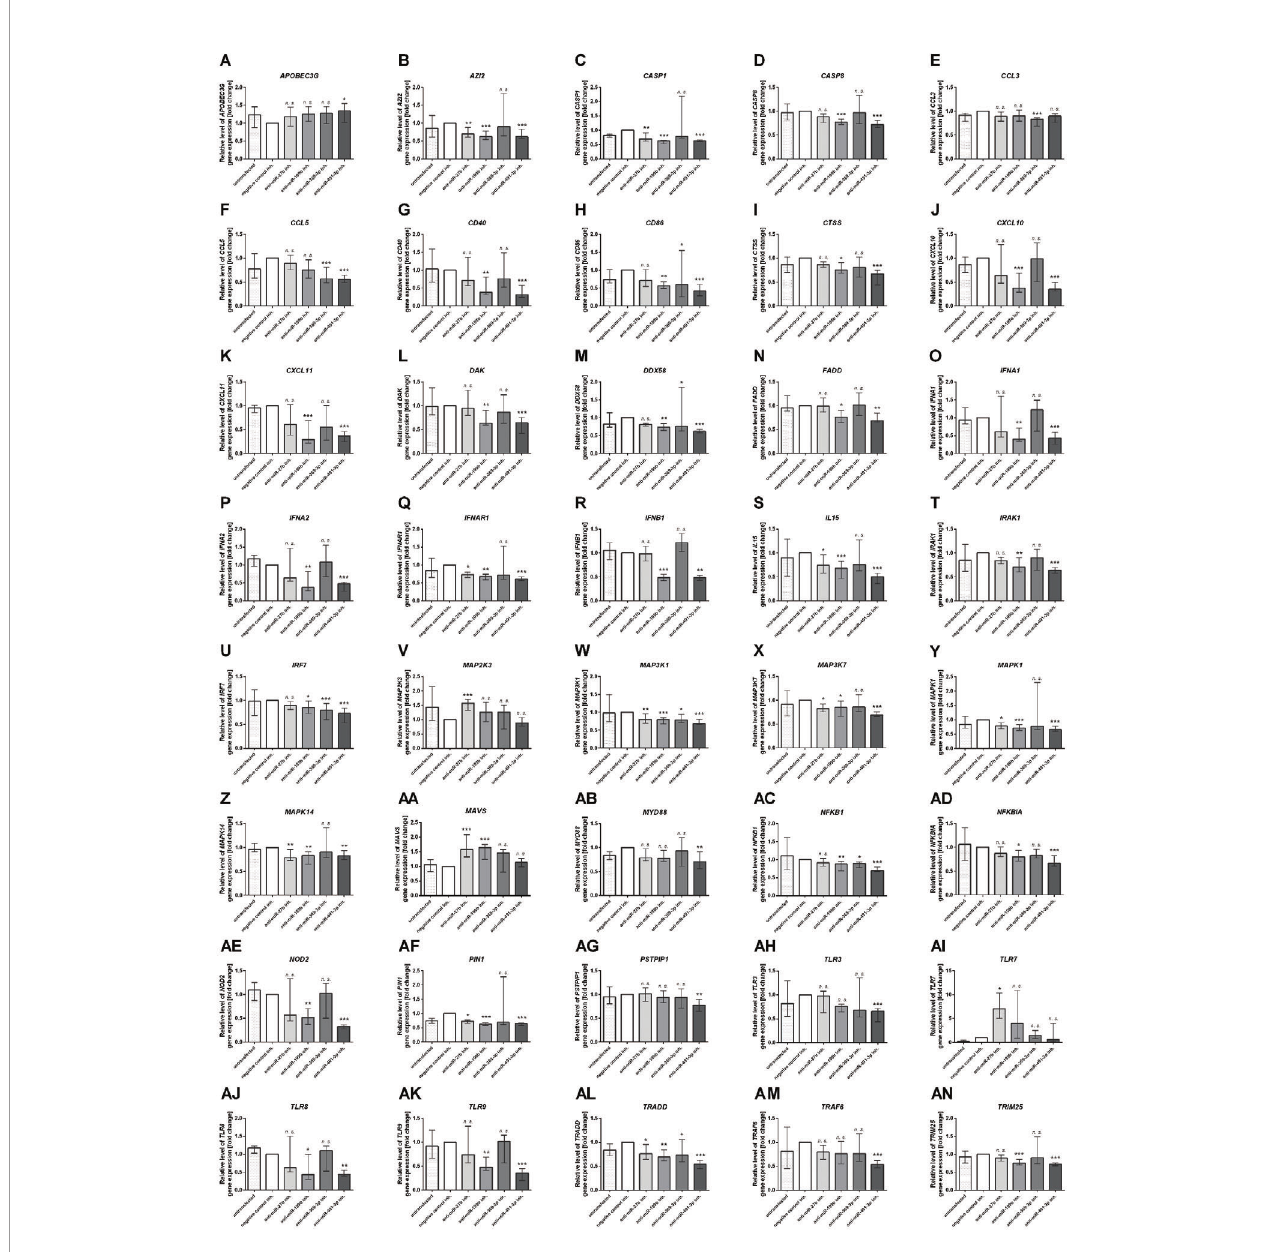
FIGURE 2 | Antiviral gene expression analysis. The effect of miR-27b, miR-199b, miR-369-3p and miR-491-3p inhibition in NK-92 cell line on antiviral response gene expression analyzed by real-time PCR presented as relative expression normalized to GAPDH (2 − DD CT ). Only genes which expression was signi fi cantly altered by at least one of the inhibitors are presented on the plot. APOBEC3G (A) , AZI2 (B) , CASP1 (C) , CASP8 (D) , CCL3 (E) , CCL5 (F) , CD40 (G) , CD86 (H) , CTSS (I) , CXCL10 (J) , CXCL11 (K) , DAK (L) , DDX58 (M) , FADD (N) , IFNA1 (O) , IFNA2 (P) , IFNAR1 (Q) , IFNB1 (R) , IL15 (S) , IRAK1 (T) , IRF7 (U) , MAP2K3 (V) , MAP3K1 (W) , MAP3K7 (X) , MAPK1 (Y) , MAPK14 (Z) , MAVS (AA) , MYD88 (AB) , NFKB1 (AC) , NOD2 (AE) , PIN1 (AF) , PSTPIP1 (AG) , TLR3 (AH) , TLR7 (AI) , TLR8 (AJ) , TLR9 (AK) , TRADD (AL) , TRAF6 (AM) , TRIM25 (AN) . Plots are presented in an alphabetic order. The data of the effect of each speci fi c miRNA inhibitor was compared to negative control inhibitor. Data was analyzed using non-parametric Kruskal-Wallis test with Dunn ’ s post-hoc test. Data from 3 independent experiments, median and interquartile range are shown. Asterisks mark signi fi cant differences: *p < 0,05, **p < 0,01, ***p < 0,001. inh., inhibitor; n. s., not signi fi